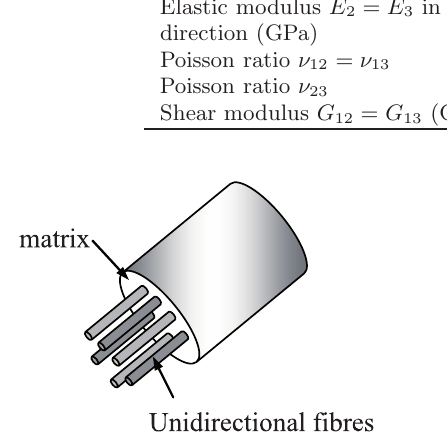
Fig. 3. Composite